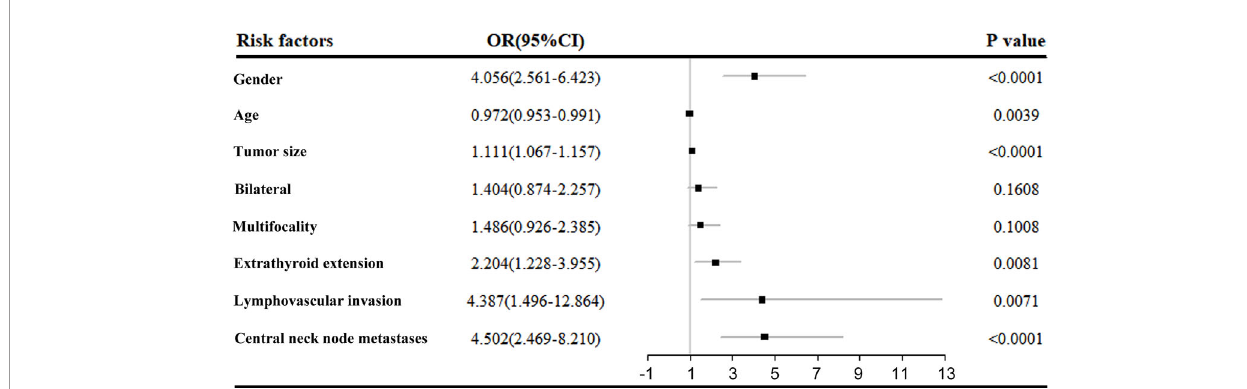
FIGURE 2 | Multivariate logistic regression analysis of DLN metastasis.